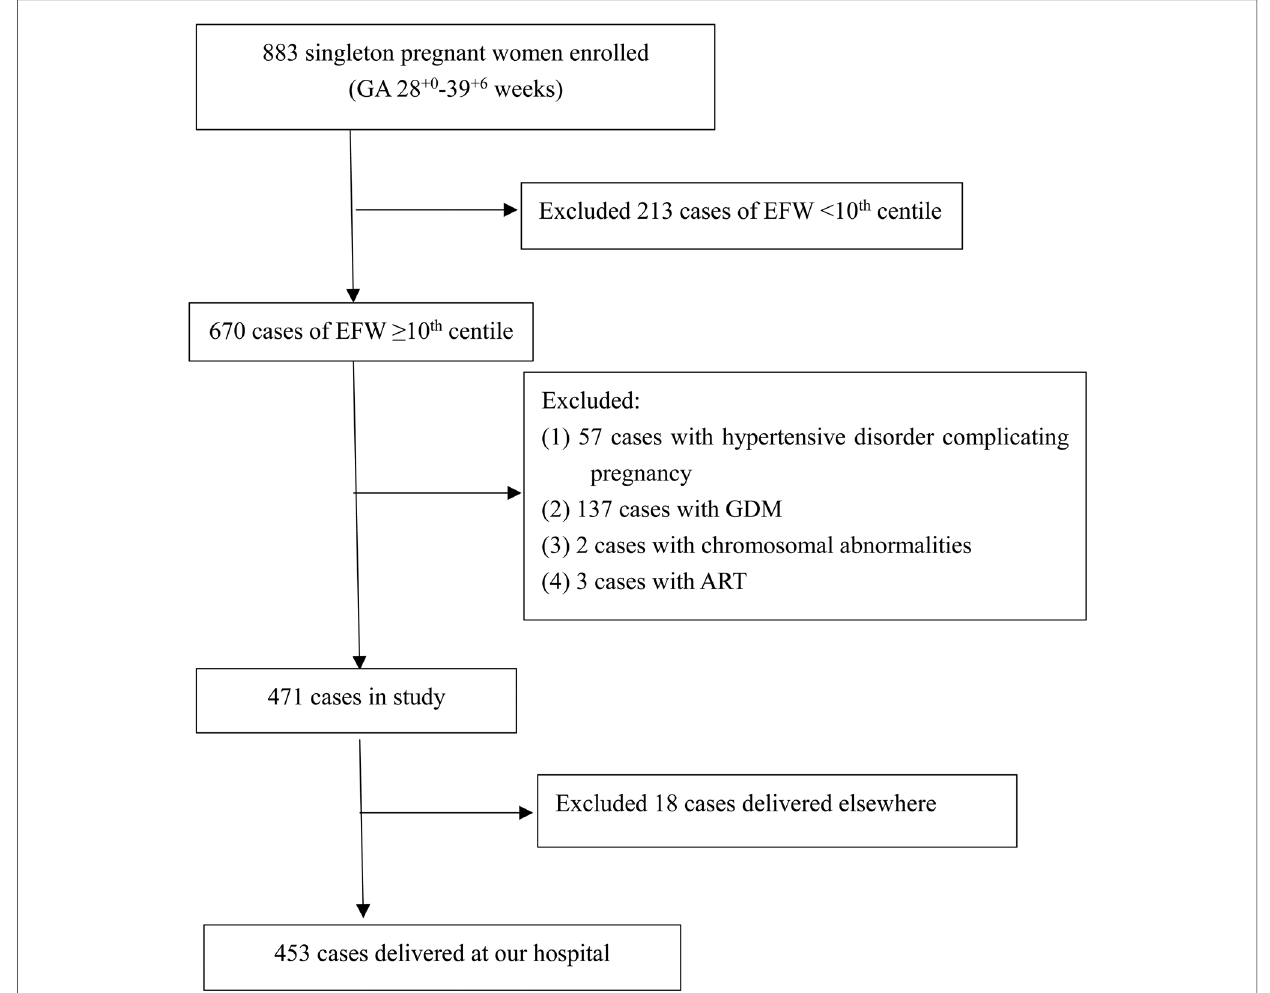
FIGURE 1 Study fl owchart. ART, assisted reproductive technology; GDM, gestational diabetes